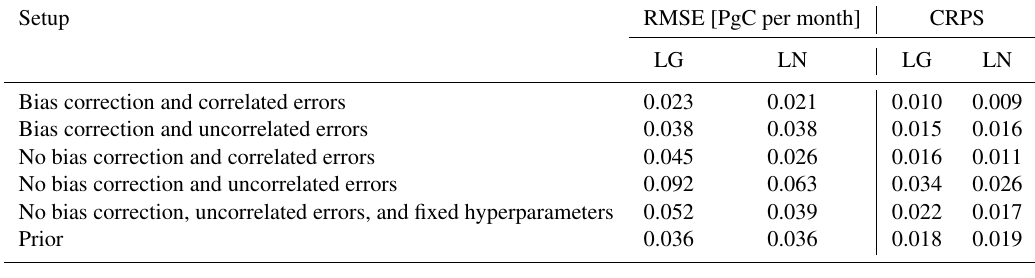
Table 3. Root-mean-squared error (RMSE) and continuous ranked probability score (CRPS) when estimating monthly regional fluxes using LG and LN data in the OSSE of Sect. 5.1. The lower the error or the score, the better the performance. Five setups in WOMBAT are evaluated, and the regions and time periods over which these summaries (averages) are obtained are the same as those used for constructing flux basis functions (see Sect. 4.2).